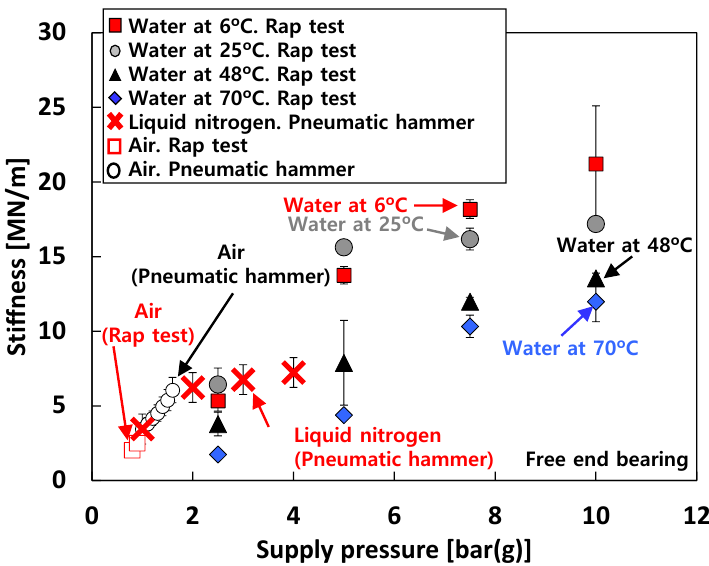
Figure 10. Test cases #1 through #3: stiffness versus supply pressure. Free end bearing.